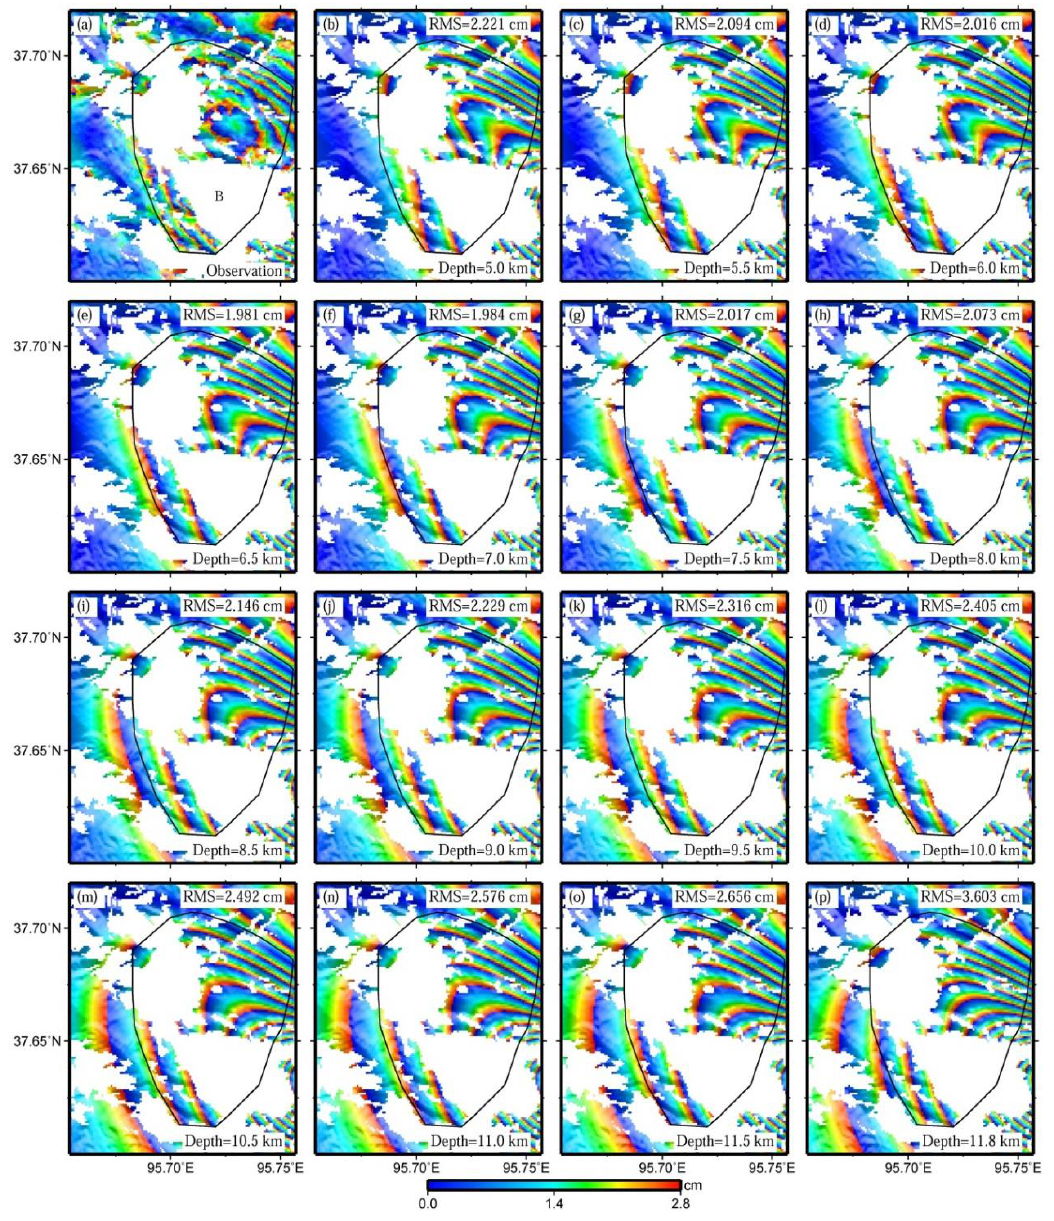
Figure 8. Observed interferogram ( a ), predicted ones with the bottom depths of fault 1 ranging from 5 km to 11.5 km at a step of 0.5 km ( b – o ), and the predicted one with